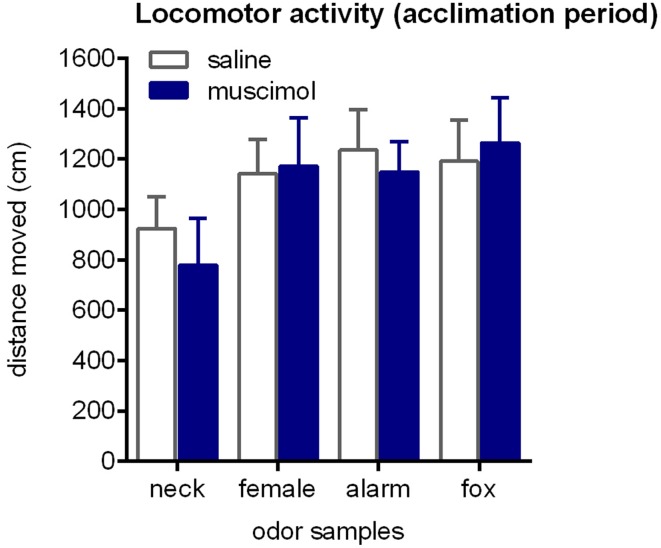
Locomotor activity during the acclimation phase. Rats were exposed to neck odor (neck), female urine (female), alarm pheromone (alarm), or fox urine (fox). Neither intra-aBNST injections of muscimol nor the type of odor samples affected distance traveled. Data are expressed as means ± SEMs.